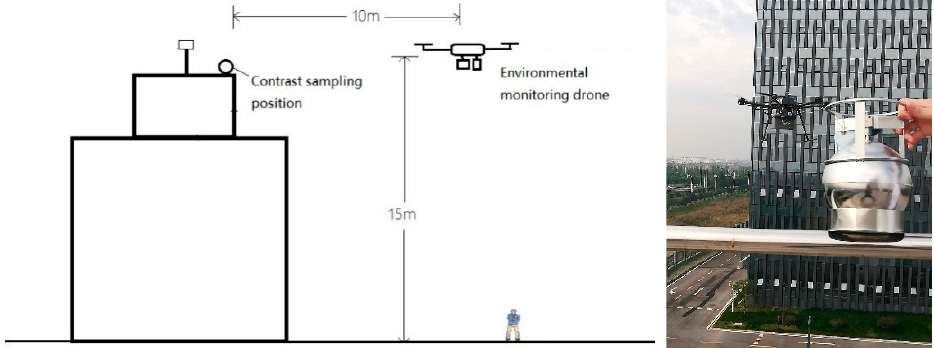
Figure 5. Schematic diagram and photo of the comparison experiment.